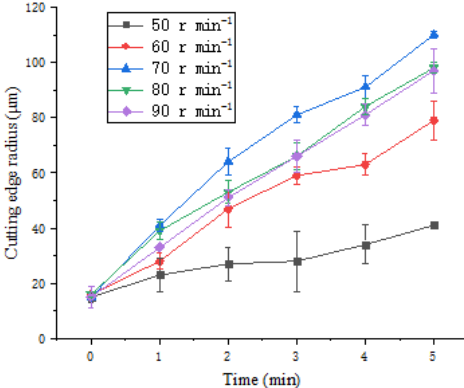
Figure 15. Experimental results under different polishing velocities.